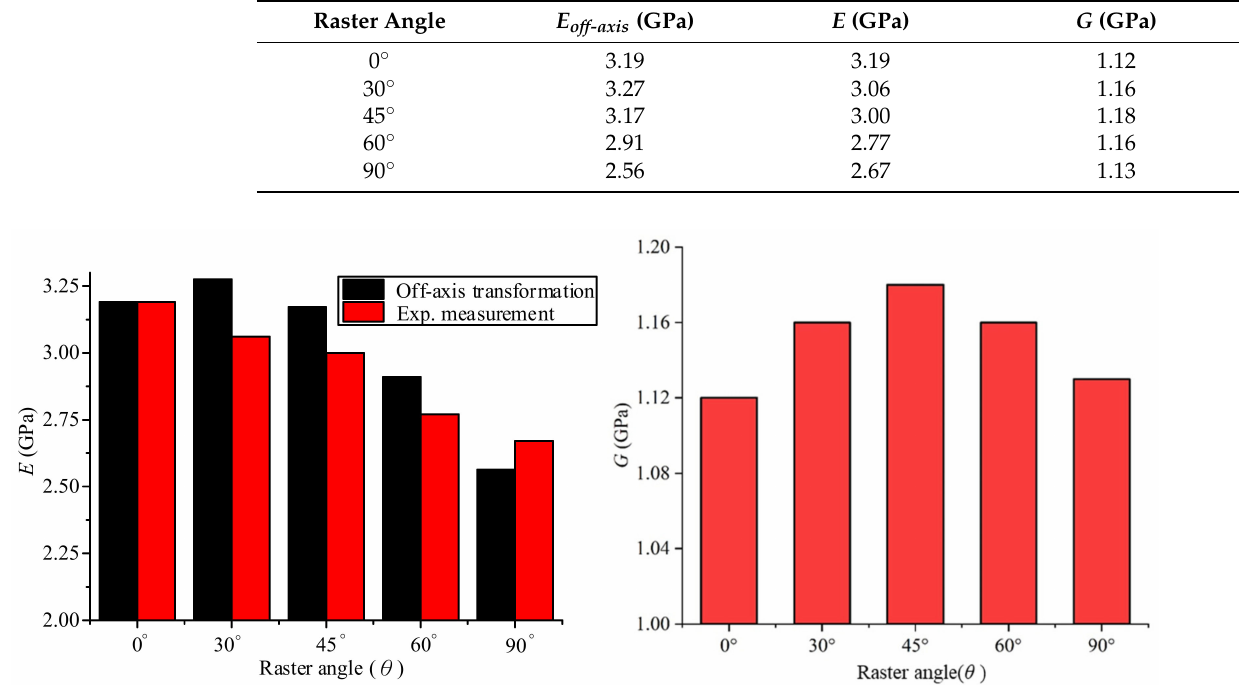
Figure 9. Material constants of test pieces with different raster